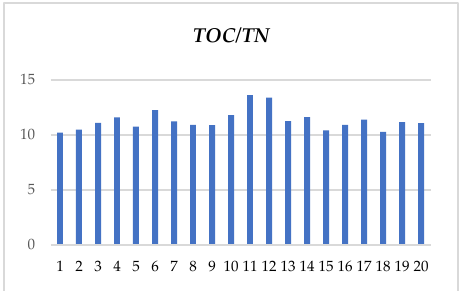
Figure 1. TOC/TN ratio in the soil.